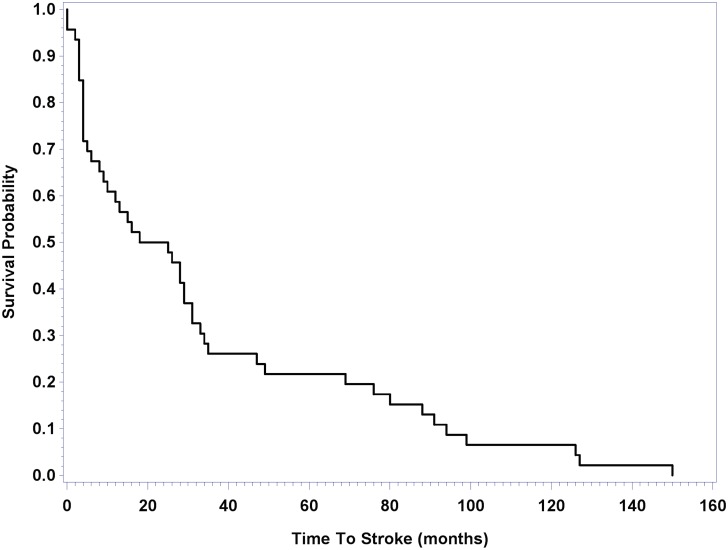
Kaplan-Meier curve representing the time from enrollment to stroke only in the cohort of MM stroke cases.